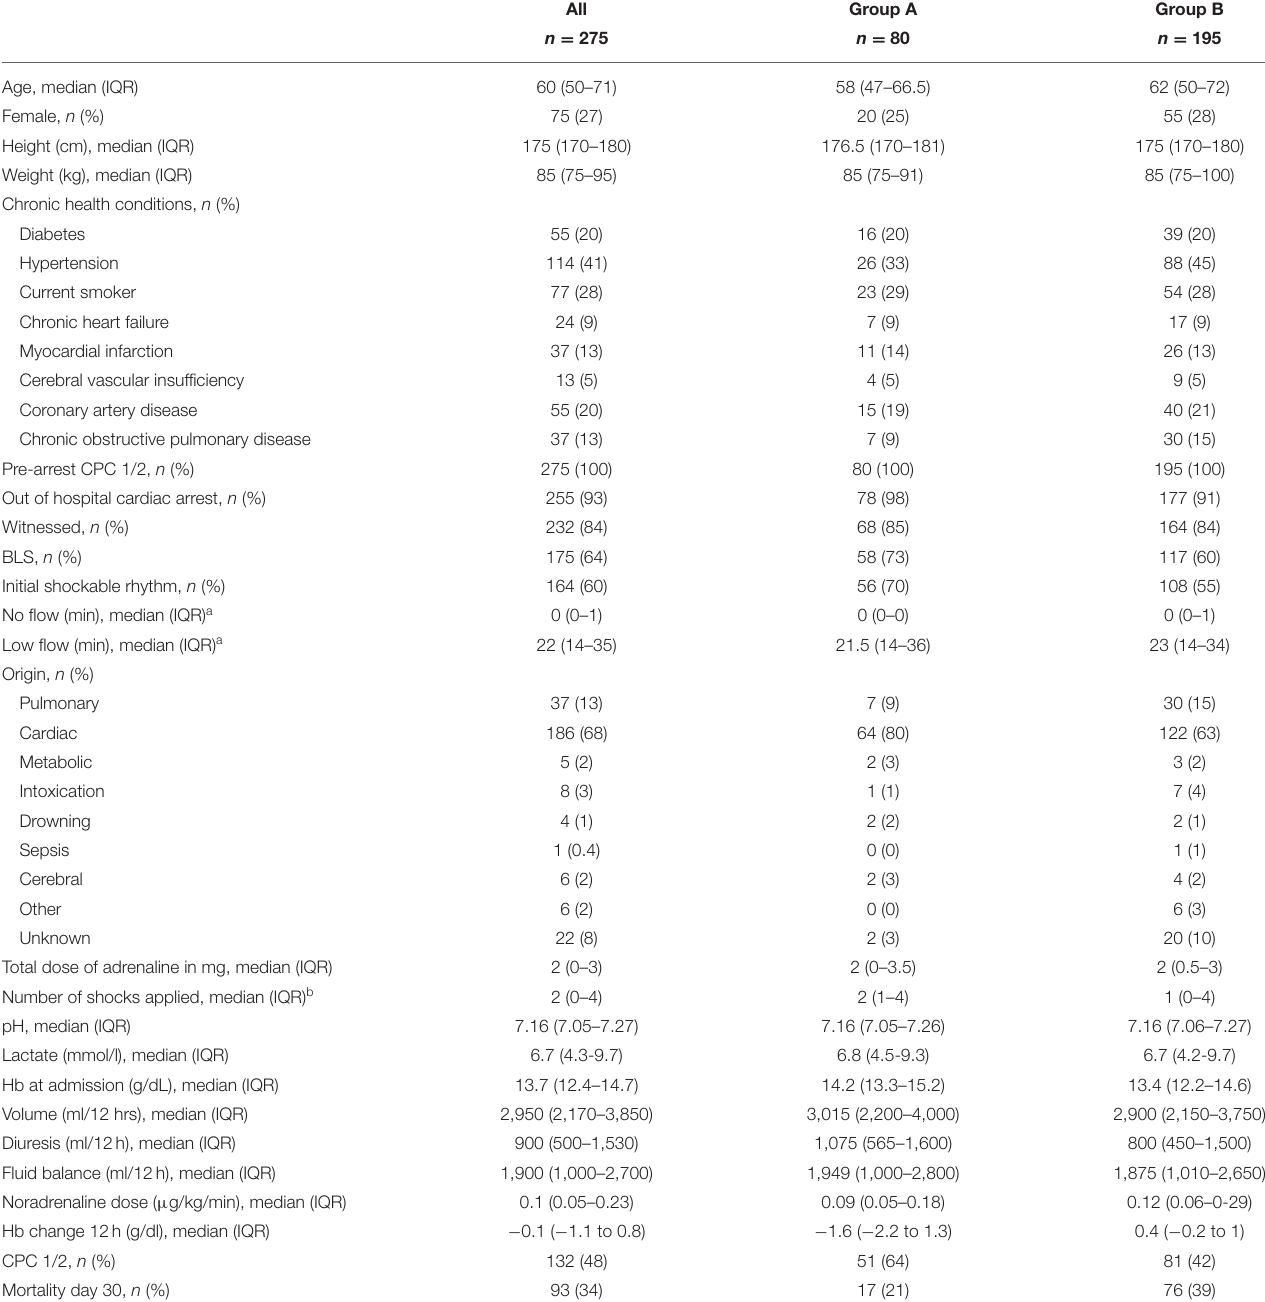
TABLE 2 | Baseline characteristics according to dHb12h